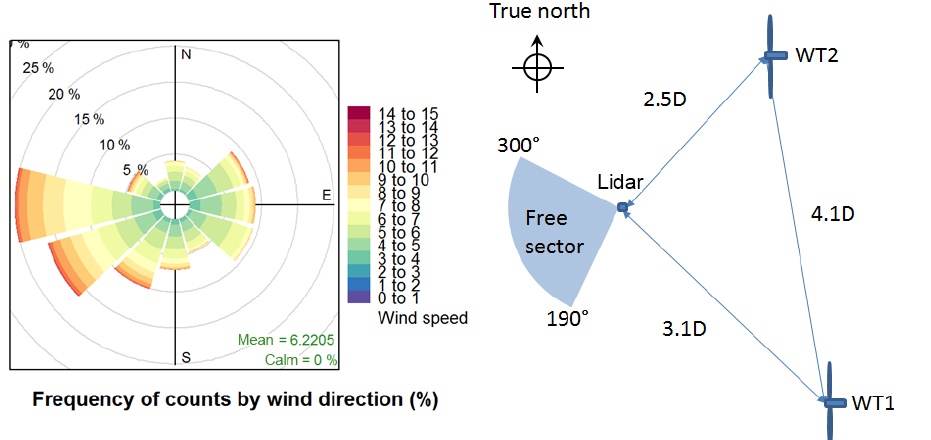
Figure 4. Layout of the test wind farm and frequency distribution of wind speeds by wind direction. Two 2MW turbines with a rotor diameter of 92m turbines and a ground-based lidar measuring inflow conditions with the velocity azimuth display technique (VAD) in the free sector are shown.